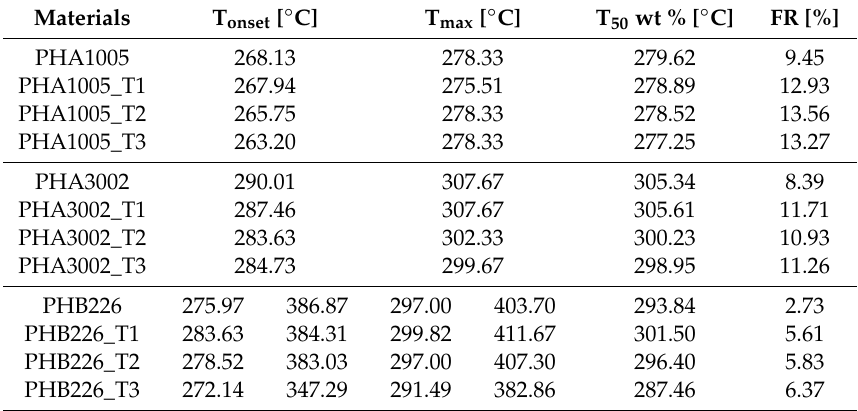
Table 3. Thermal results obtained by TGA. T onset %, T max %, and T 50 % represent the temperature of the initial degradation, the maximum degradation rate of decomposition, and 50 wt % loss of the samples, respectively. FR represents the final residue and DTG first